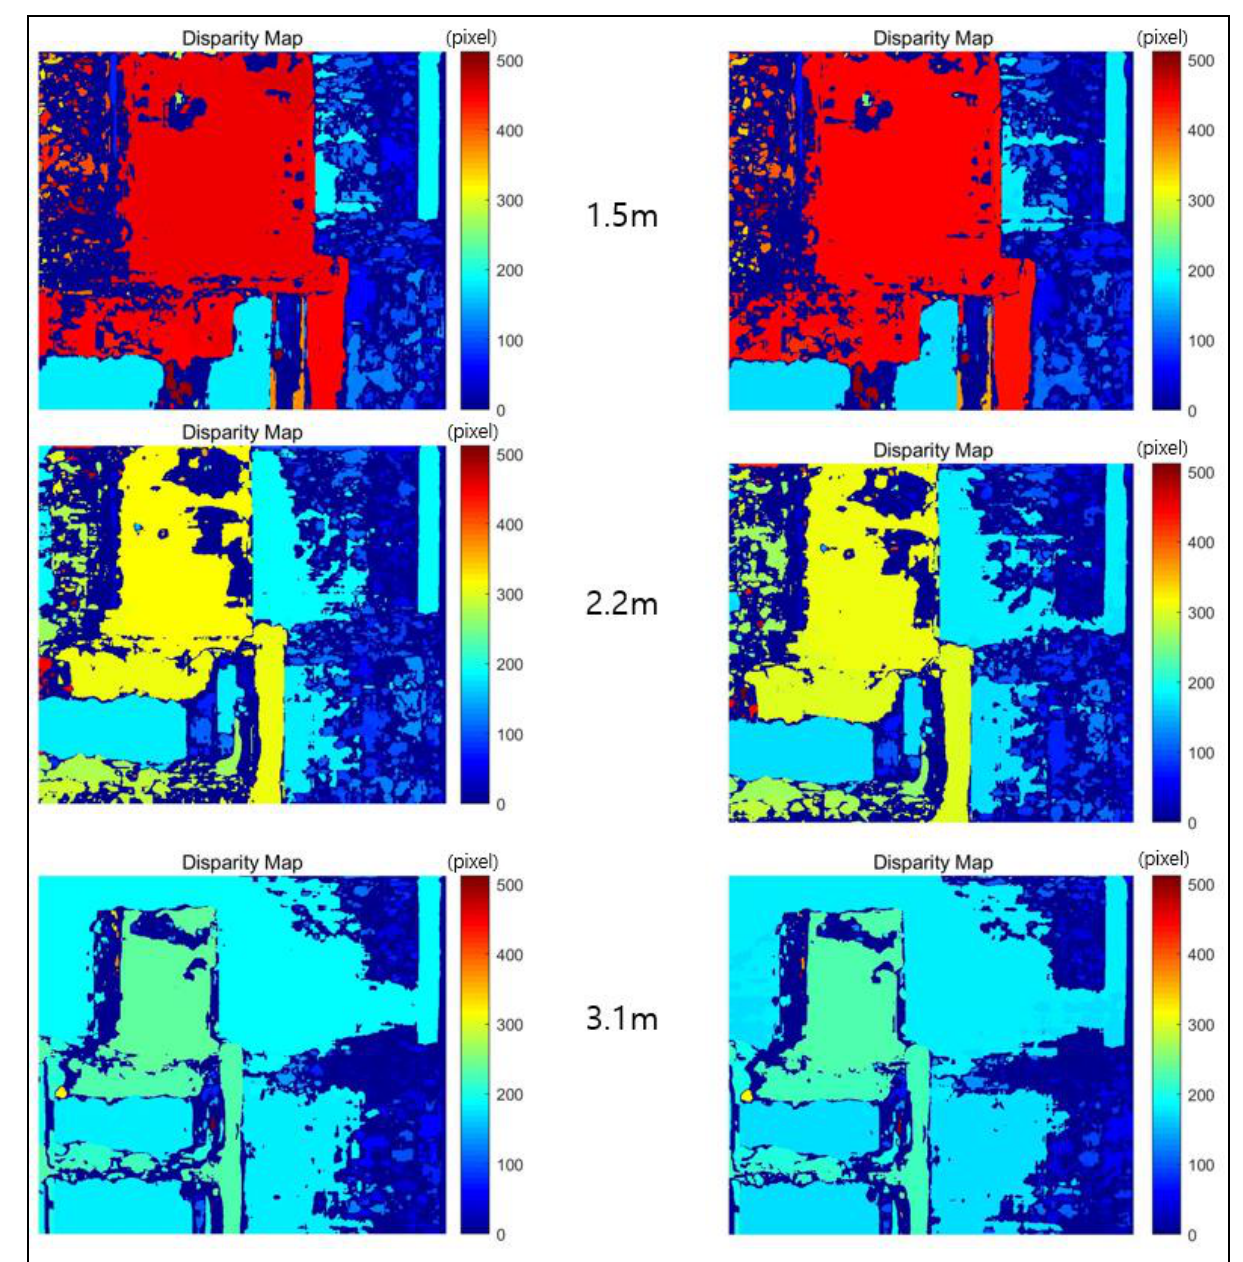
Figure 23. The generation of the disparity map of Zhang’s algorithm and proposed algorithms.